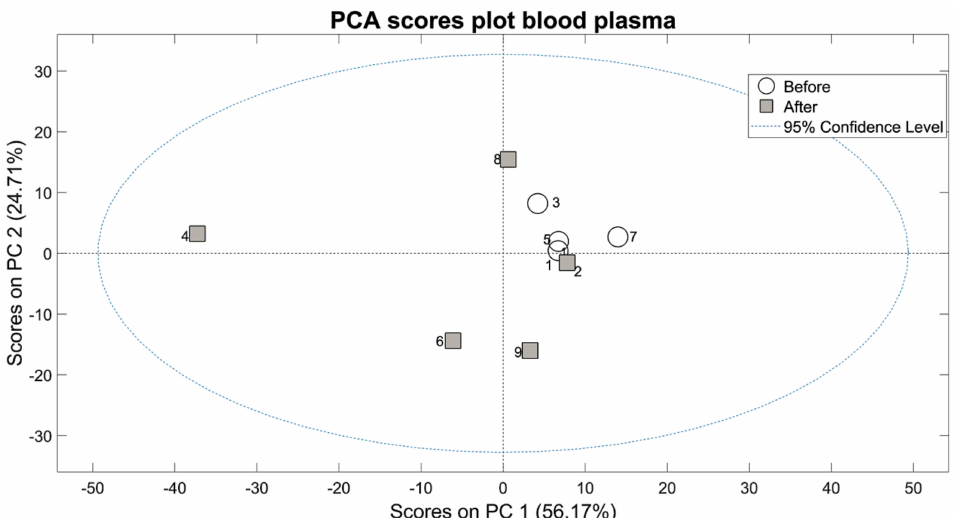
Figure 2. Scores plot for the PCA of NMR spectra of blood plasma. PC1 and PC2 account together for 81% of the total variance of the metabolic profiles of all samples. Each point in the plot represents the global metabolic profile of one sample. Proximity in the PCA scores plot bidimensional space represents similarity in the global metabolic profile. Samples before (white circles) and after (gray squares) wine intervention show clear separation.